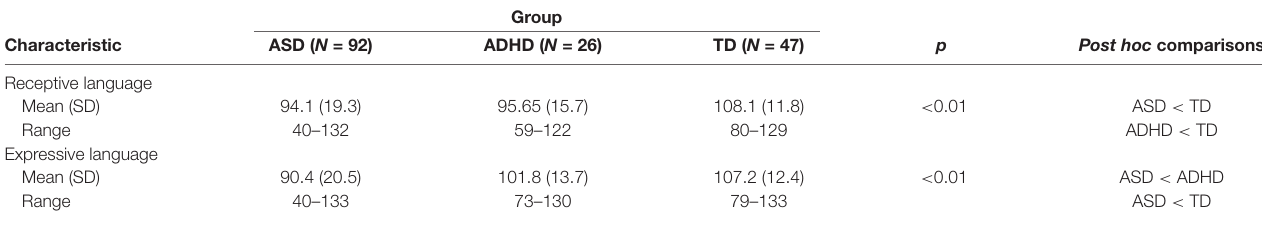
TABLE 2 | Receptive and expressive language abilities across diagnostic groups.